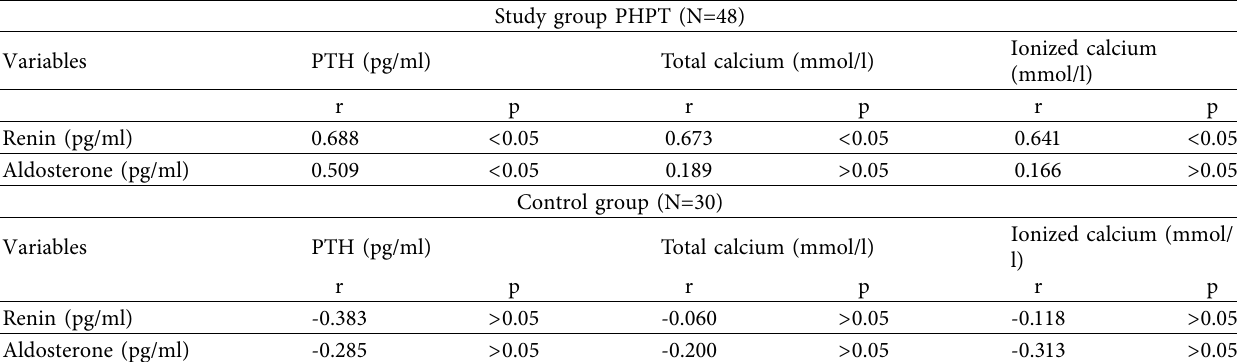
Figure 2: Correlation between PTH and aldosterone in the study group ( r � 0.509, p < 0.05). Table 3: Correlation in the study and the control group for the examined